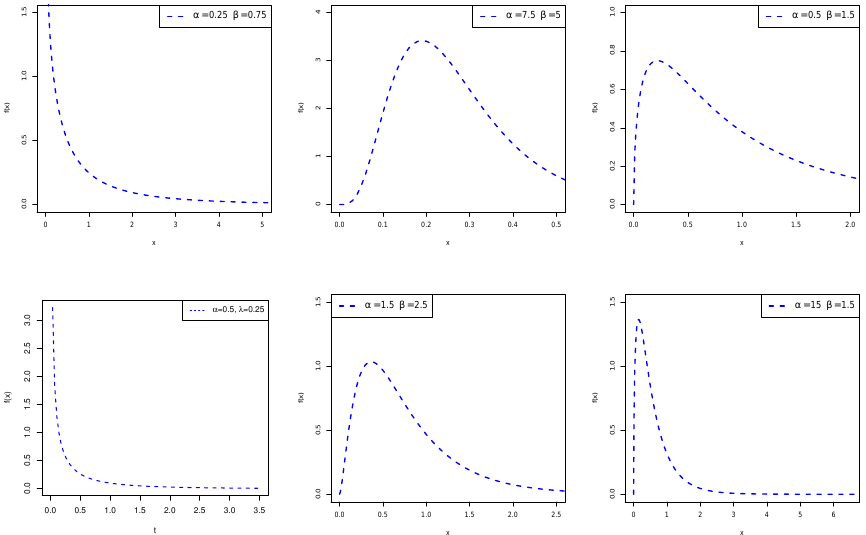
Figure 1. Some possible shapes for the PDF of the EBuH